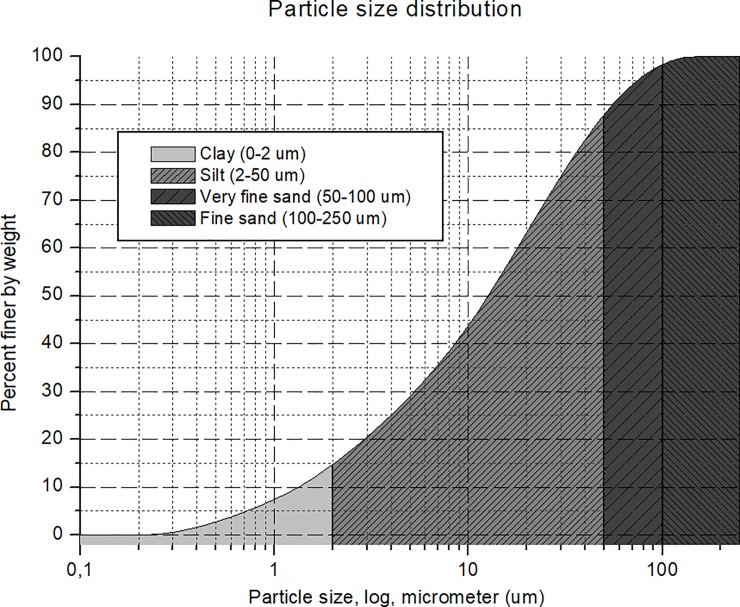
Size distribution of the sedimented soil material, determined by laser diffractometry.Note: The soil was not submitted to chemical pre-treatment for disaggregation.